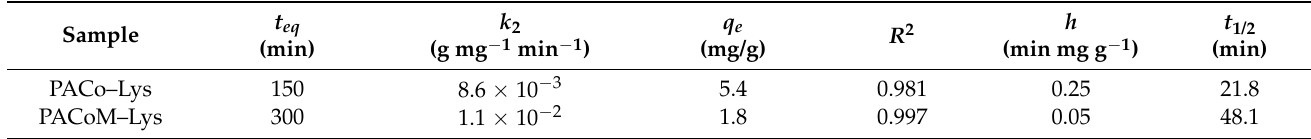
Figure 9. Fitting of adsorption kinetic data using the linearized form of PSO. Table 3. Kinetic parameters calculated from the PSO model for ASA adsorption.